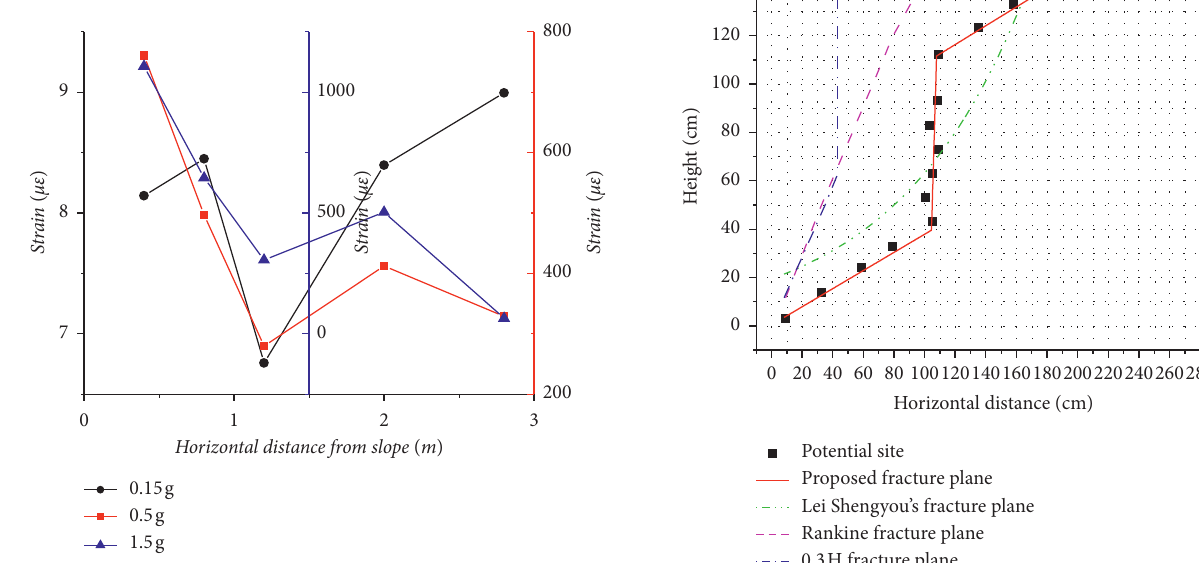
Figure 8: Distribution of strain along the horizontal direction of the main rib section of the first layer of geogrid.